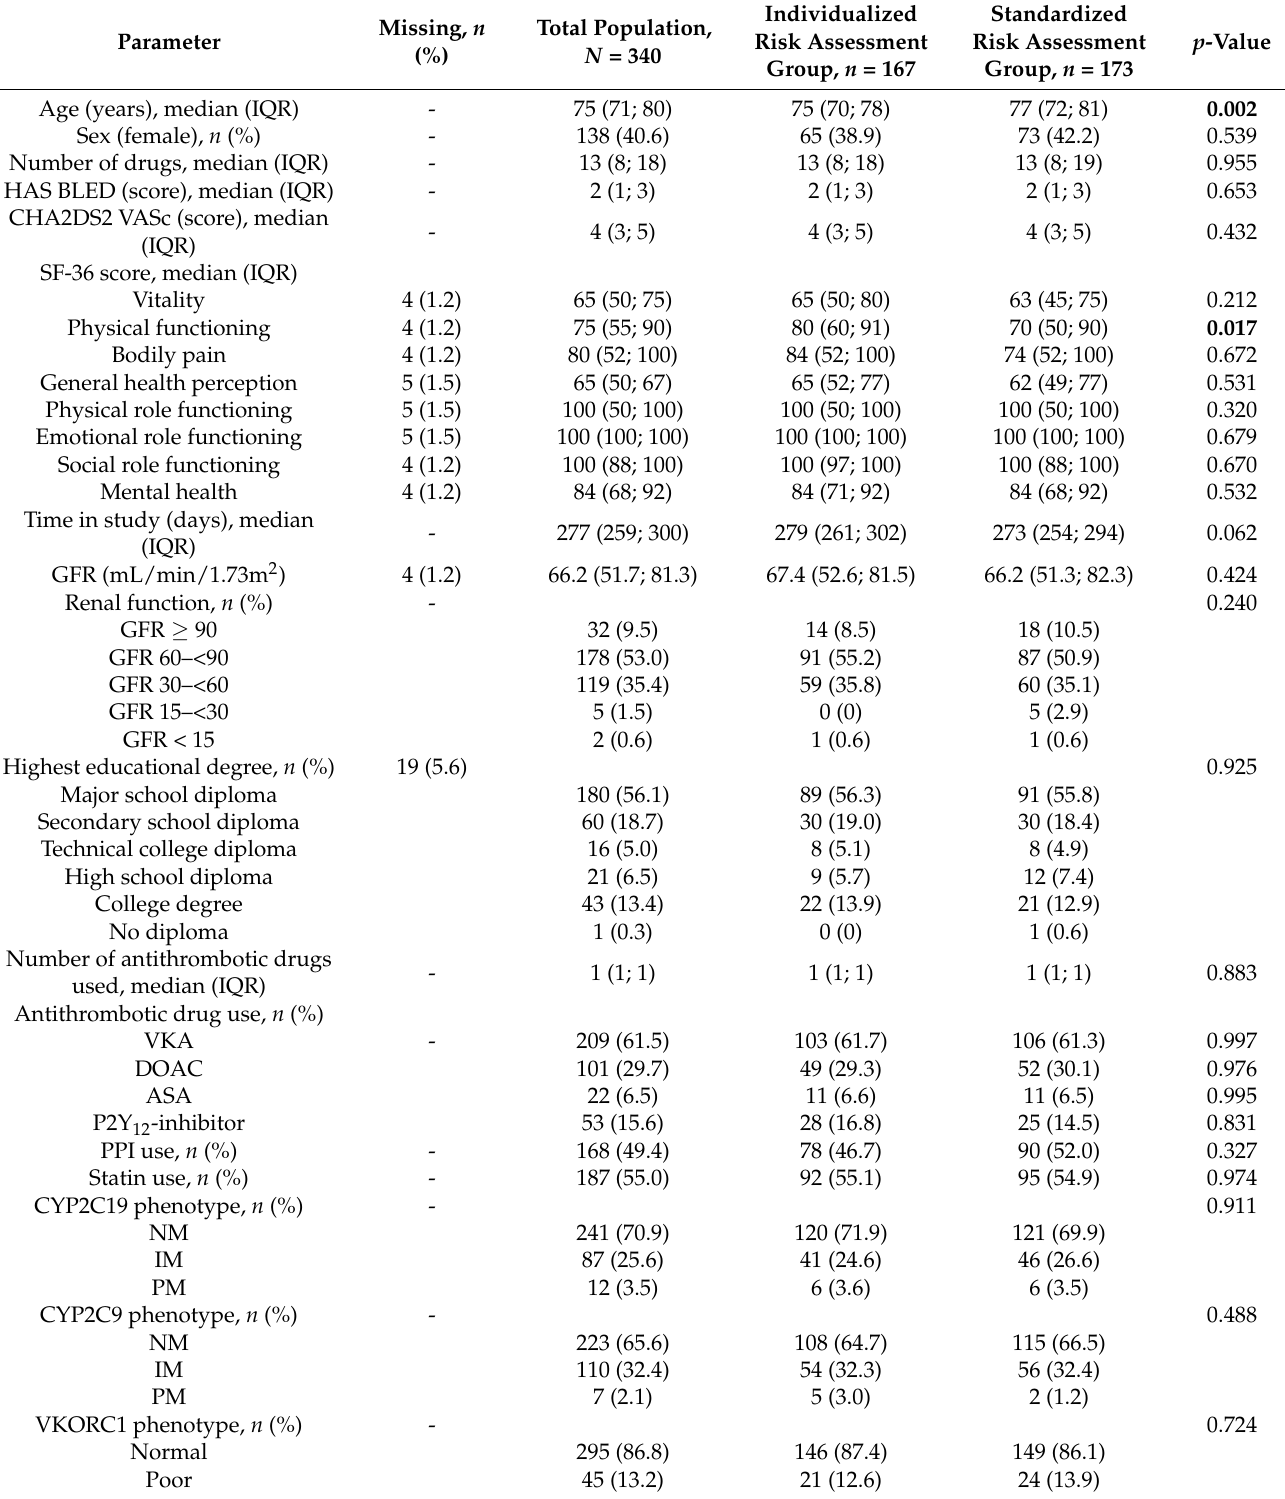
Table 1. Characteristics of the total population and stratified according to individualized and standardized risk assessment groups ( N =